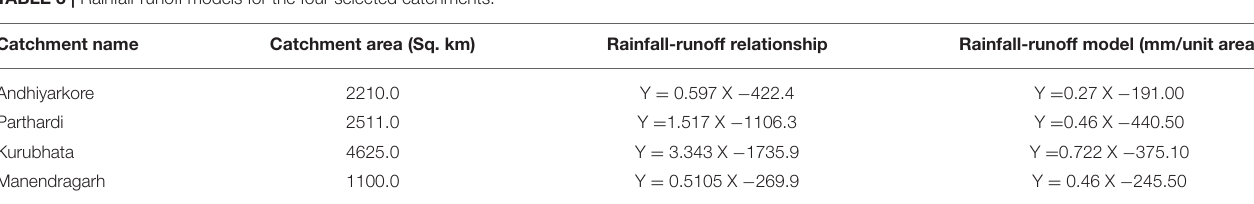
TABLE 3 | Rainfall-runoff models for the four selected